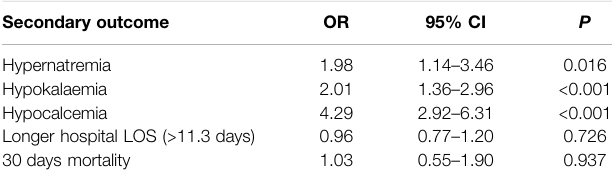
TABLE 3 | Multivariate logistic regression of sodium bicarbonate infusion for secondary outcome. Secondary outcome OR 95% CI P